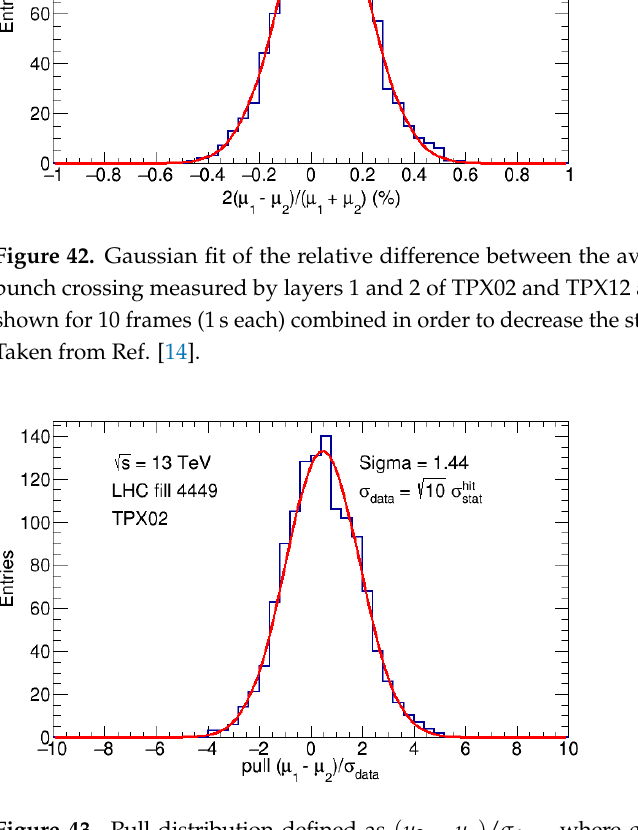
Figure 43. Pull distribution defined as ( µ 2 − µ 1 ) / σ data , where σ data = N cl = 10 for TPX02. The data shown in Figure 42 are used. LHC fill 4449. Taken from Ref.